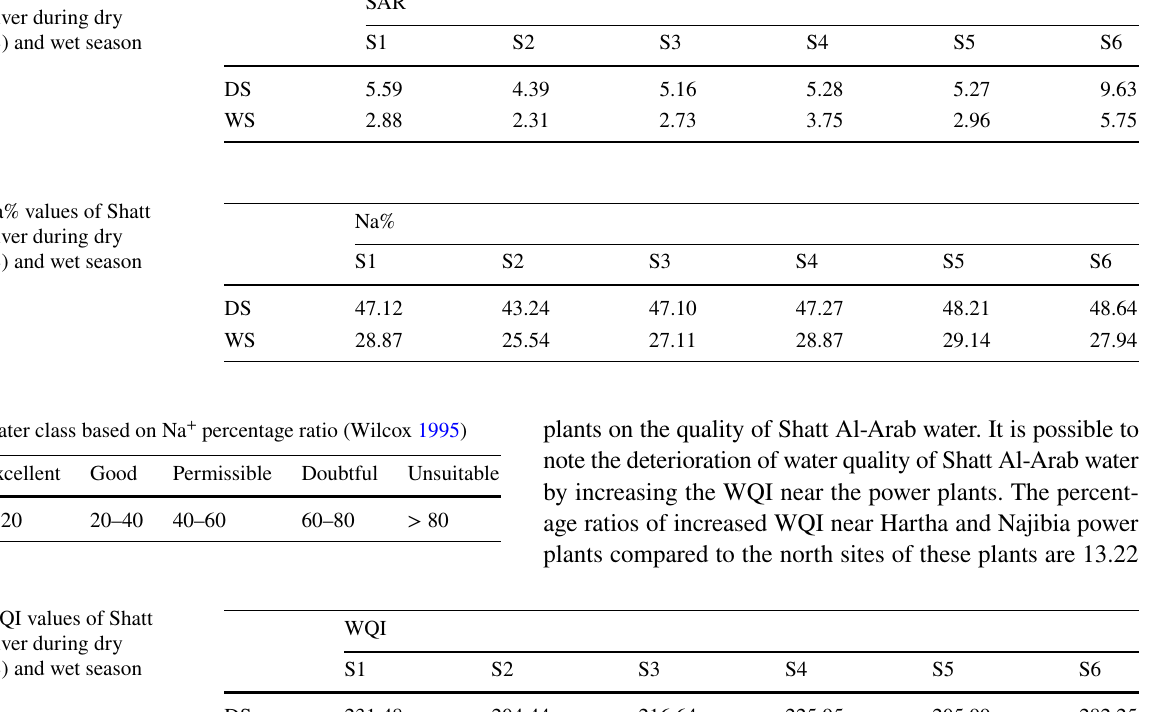
Table 5 SAR values of Shatt